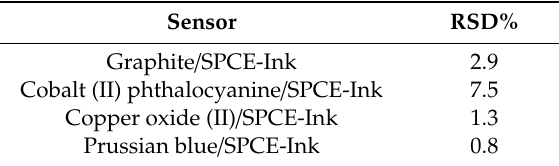
Table 2. Reproducibility of construction of each sensor with the results of the relative standard deviation (RSD).